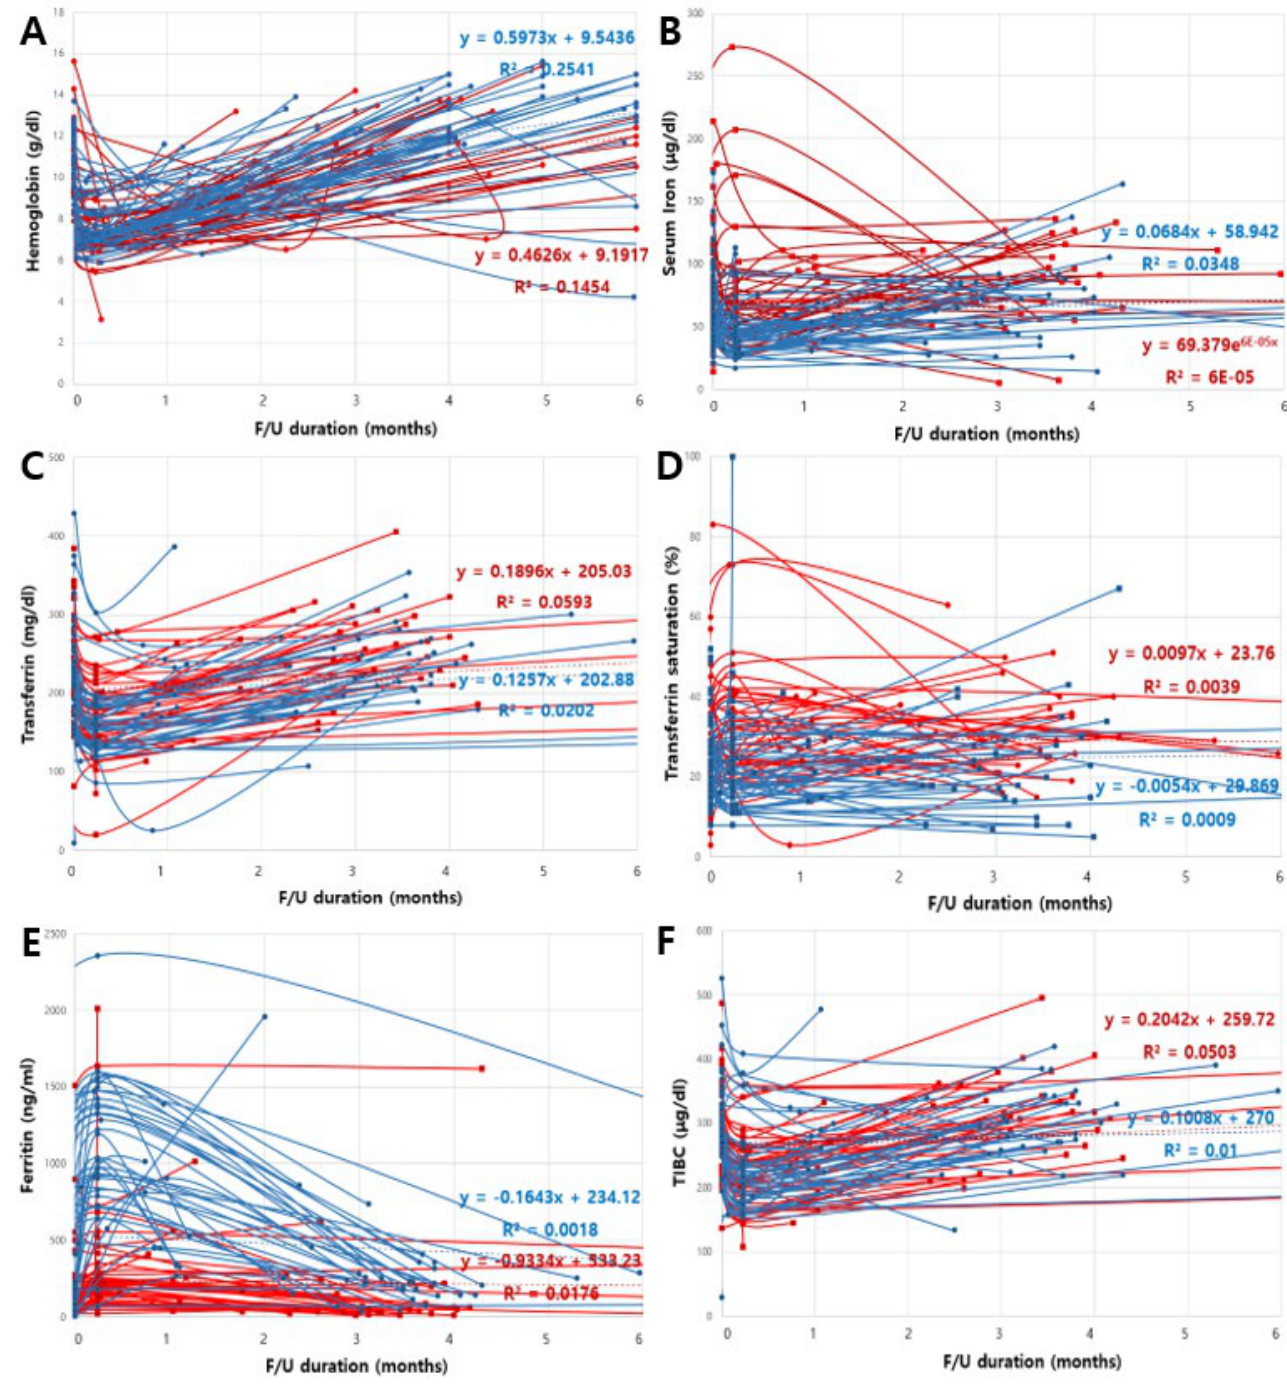
Figure 2. Spaghetti plots of the changes in the hematologic parameters over time after coronary artery bypass in the intravenous ferric carboxymaltose (IVFC) group (—) vs. the placebo group (—) for patients receiving preoperative intravenous iron. ( A ) Hemoglobin, ( B ) Serum iron concentration, ( C ) transferrin concentration, ( D ) transferrin saturation, ( E ) ferritin concentration, and ( F ) total iron-binding capacity (TIBC). F/U, follow-up.